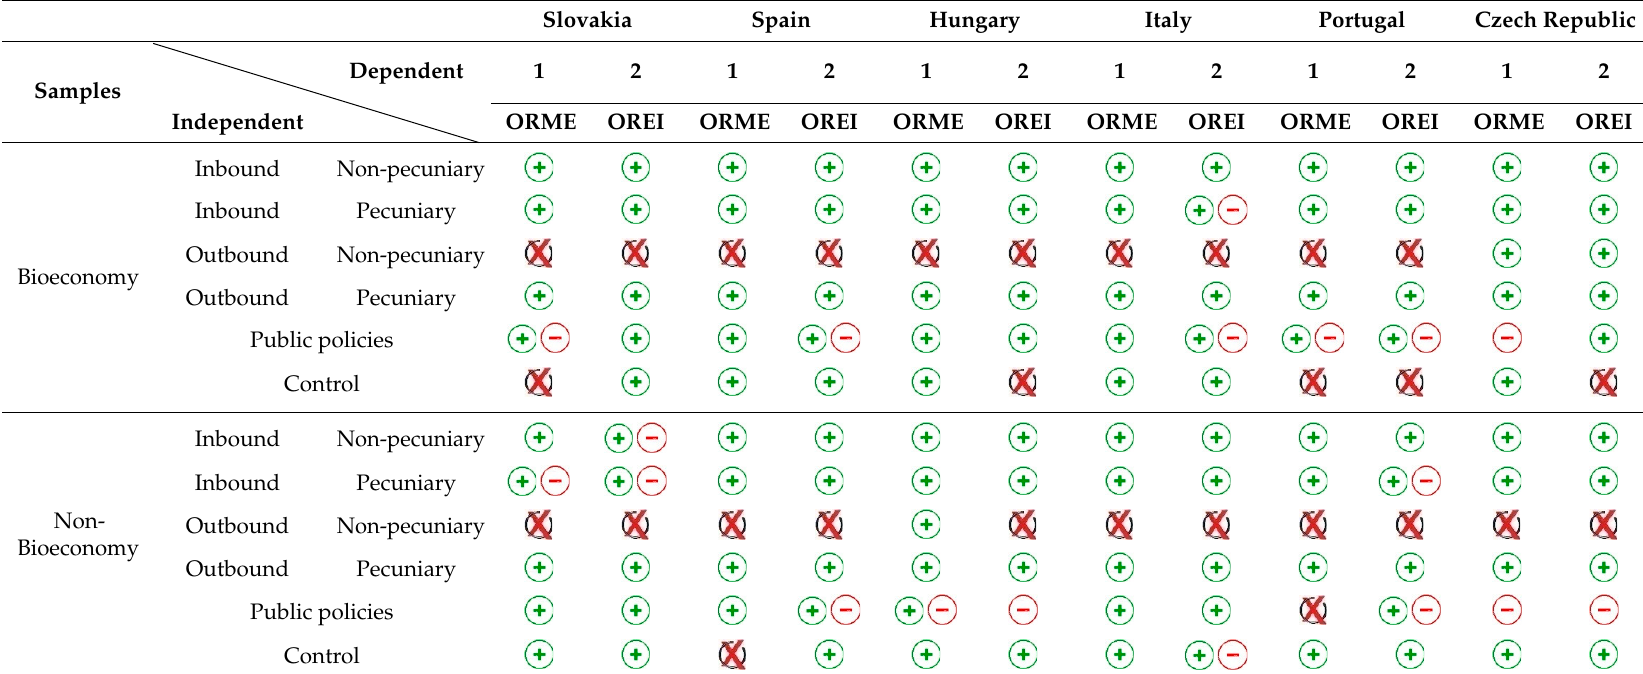
Legend: 1. Process innovation | 2. Product innovation. Source: Own elaboration.